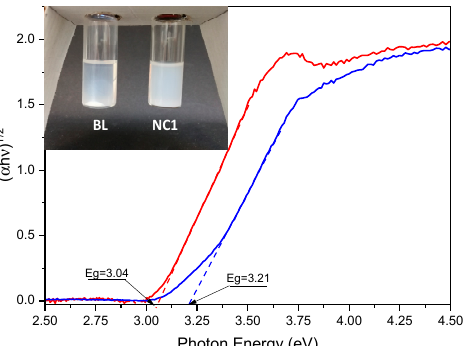
Figure 2. Calculation of the optical band gap of NC1 ( blue ) and BL ( red ) through the Tauc plot method. Inset: digital image of BL and NC1 THF solutions after 24 h storage.